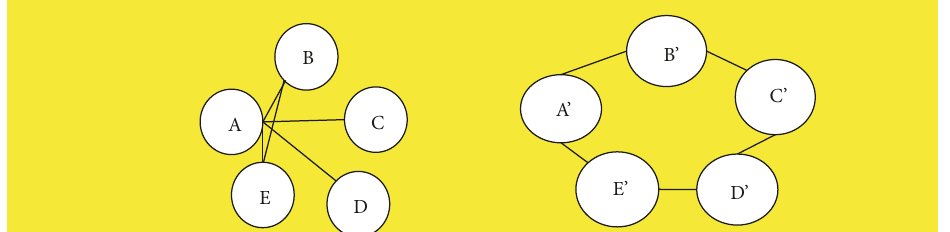
Figure 4: A simple example of measuring investor influence.